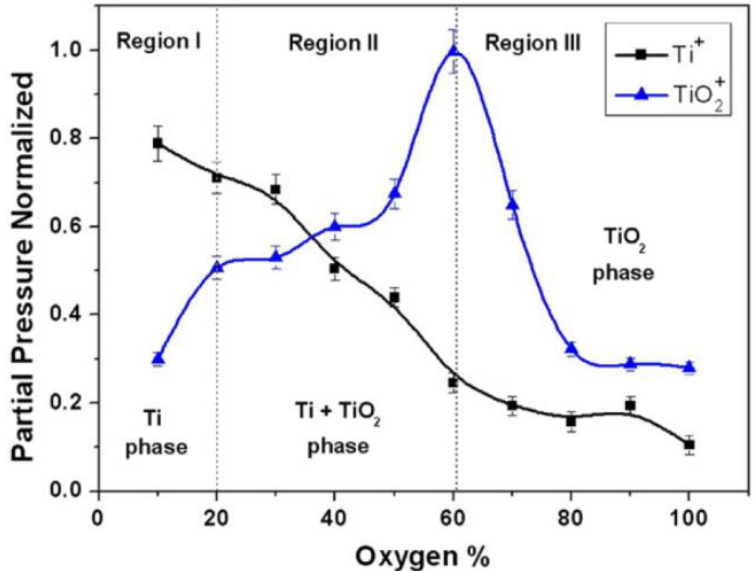
Figure 10. Variation of intensity of Ti + and TiO 2 + species as a function of O 2 %. Partial pressures are normalized to 1 at maximum value. Reprinted with permission from [107], copyright 2008, Elsevier.